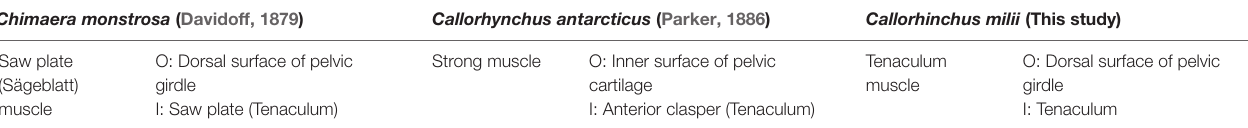
TABLE 6 | Points of origin (O) and insertion (I) of the muscle associated with the pre-pelvic tenaculum. Chimaera monstrosa (Davidoff,